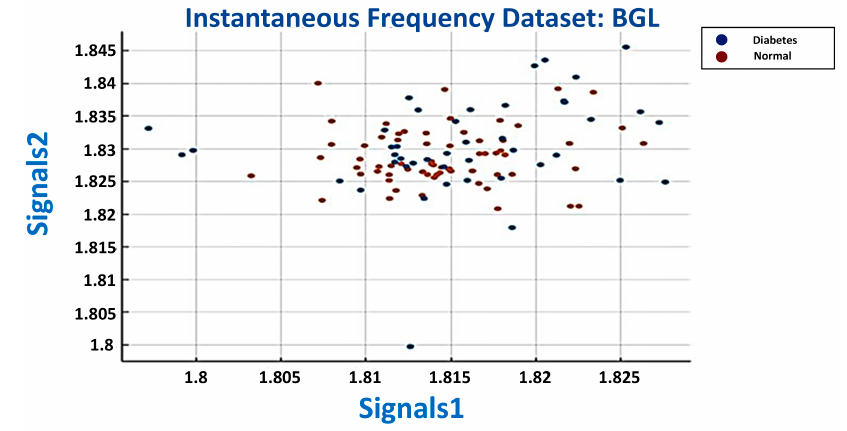
Figure 13. Data distribution of instantaneous frequency PPG signal. Table 4. Comparative analysis of training results.